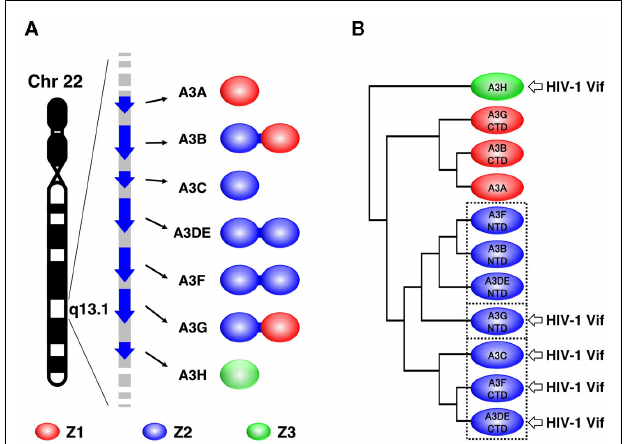
FIGURE 1 |Three types of Z domains in humanA3 family. (A) Seven members of human A3 family, encoded by human chromosome 22, are illustrated.The protein products consist of one or two Z domains, each of which is phylogenetically grouped into three distinct types: Z1, Z2, and Z3. (B) Three subgroups of the Z2 domains are enclosed with dotted lines in the phylogenetic tree.The arrows point to the domains that are responsible for HIV-1Vif interaction.